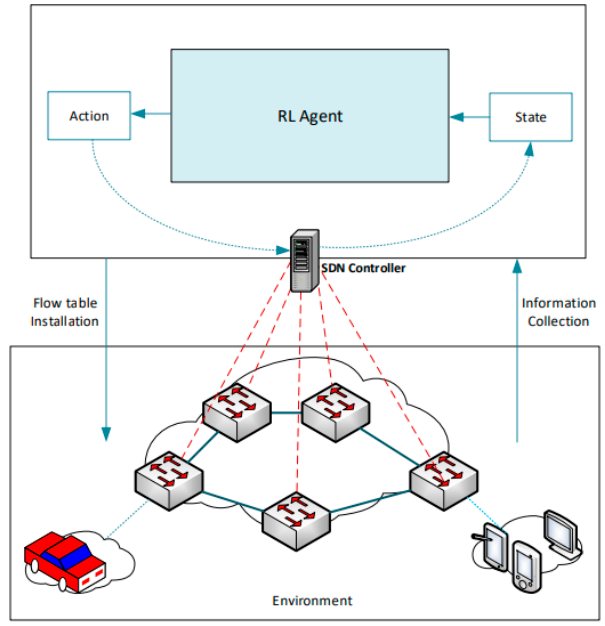
Figure 3. SARL. Figure 3.